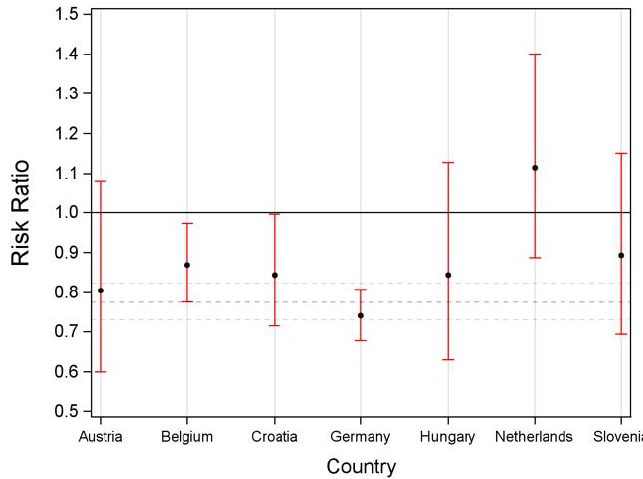
Figure 1. Risk ratio for transplantation depending on sex by country.